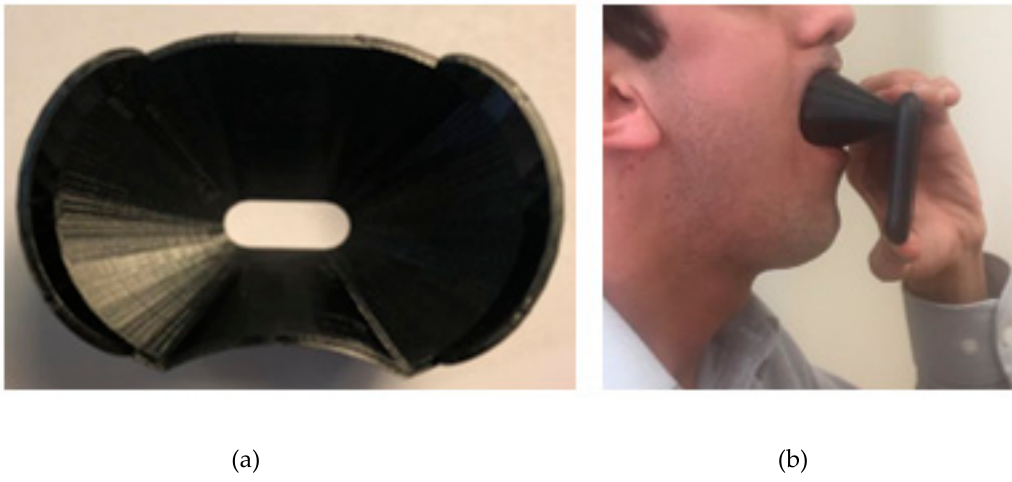
Figure 2. Our developed add-on gadget and its usage for data acquisition. ( a ) Add-on gadget designed and manufactured by 3D printing, and ( b ) image acquisition setup using the iPhone X with the add-on gadget.